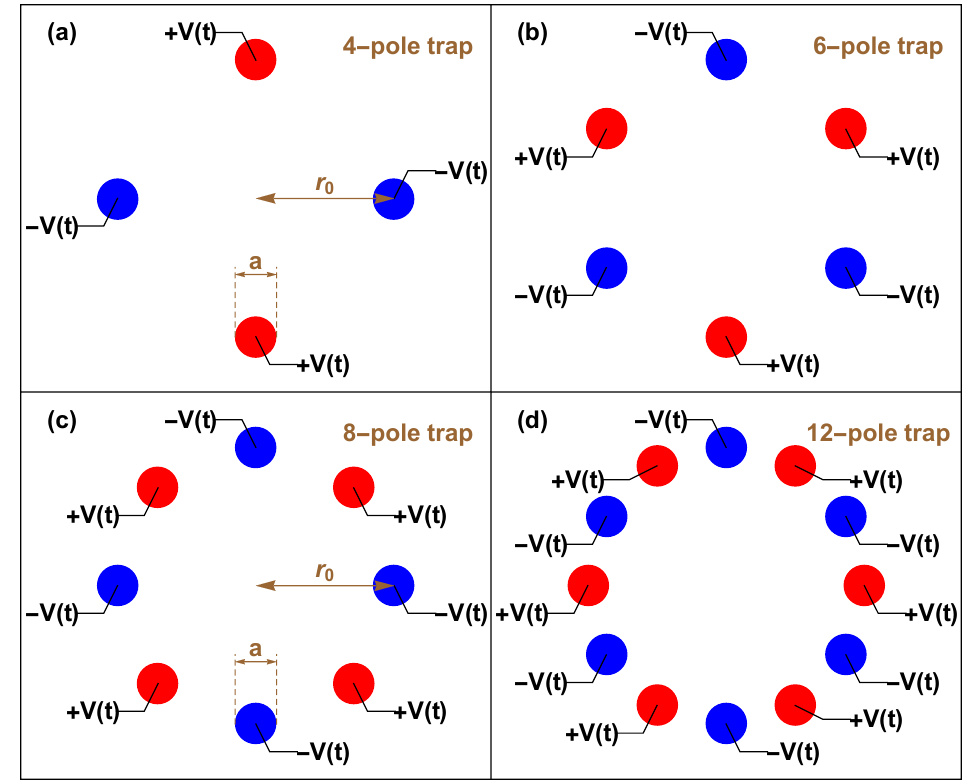
Figure 1. Electrode potential configuration for normal operation of ( a ) a 4-pole trap, ( b ) a 6-pole trap, ( c ) an 8-pole trap and ( d ) a 12-pole trap, where V ( t ) = V 0 sin ω t . We keep the parameters r 0 and a fixed for all the trap configurations. Note that the 12-pole trap in ( d ) is also equivalent to the superposition of three quadrupole traps ( e 1 , e 4 , e 7 , e 10 ) ,( e 2 , e 5 , e 8 , e 11 ) and ( e 3 , e 6 , e 9 , e 12